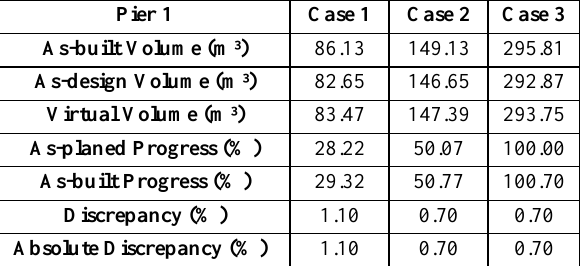
Table 1. The numerical results and construction progress in percentage for Pier 1.